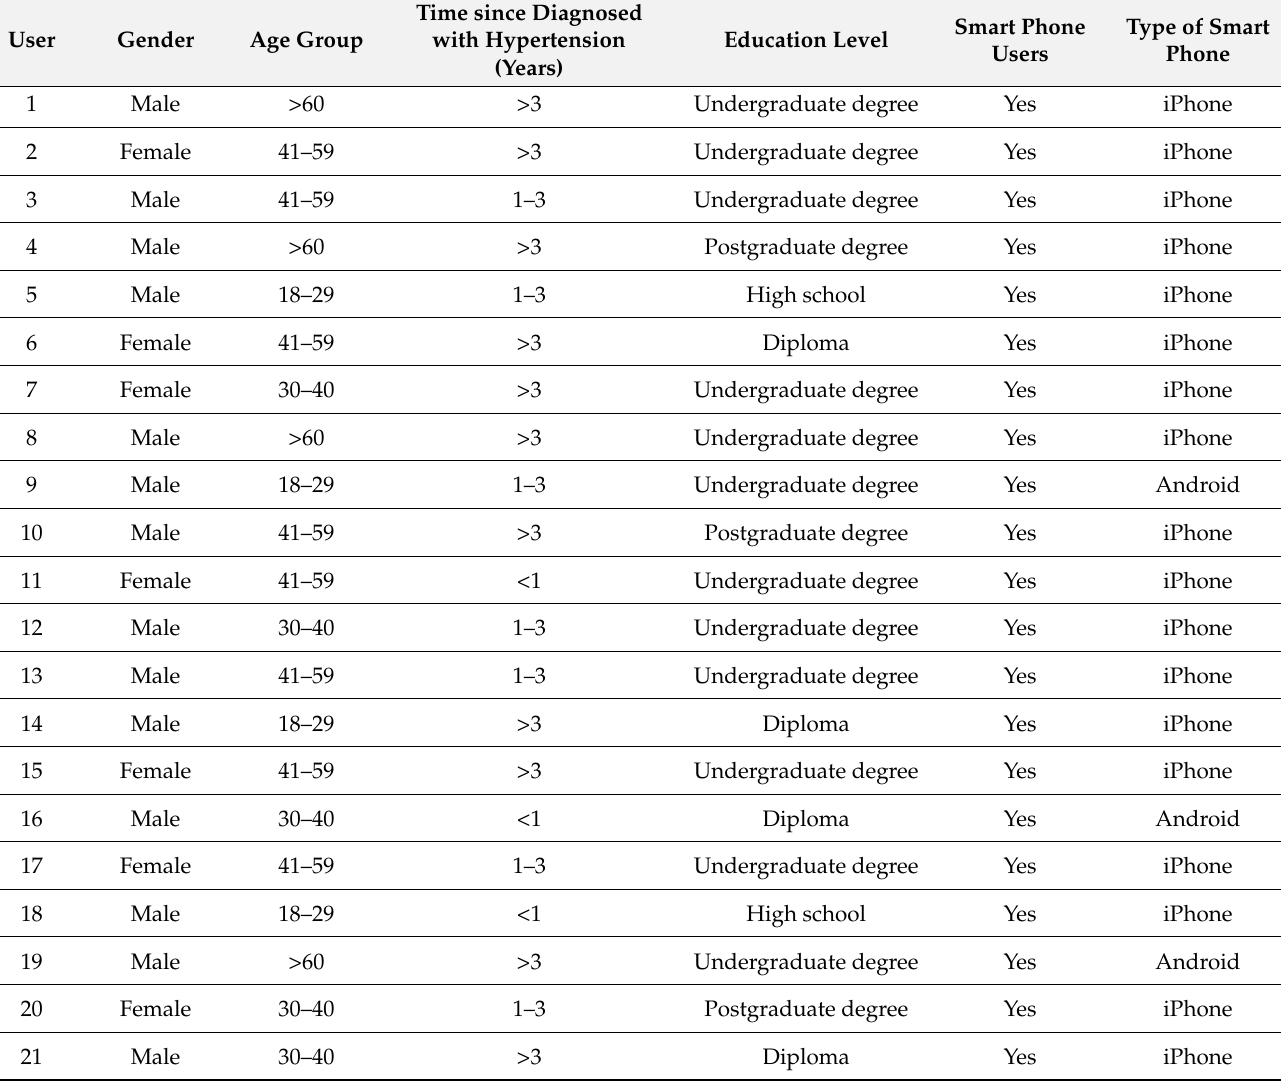
Table 1. Presence of characteristics among the participants n =